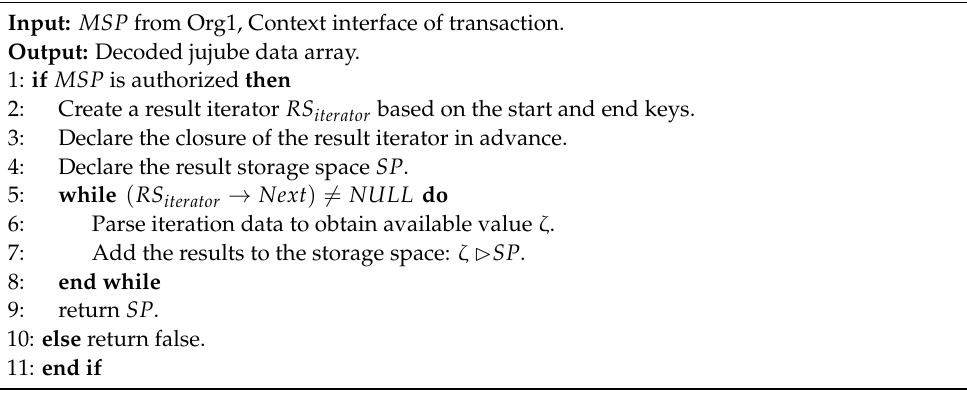
Algorithm 1 Process of Reading Jujube Data in the Common Transaction